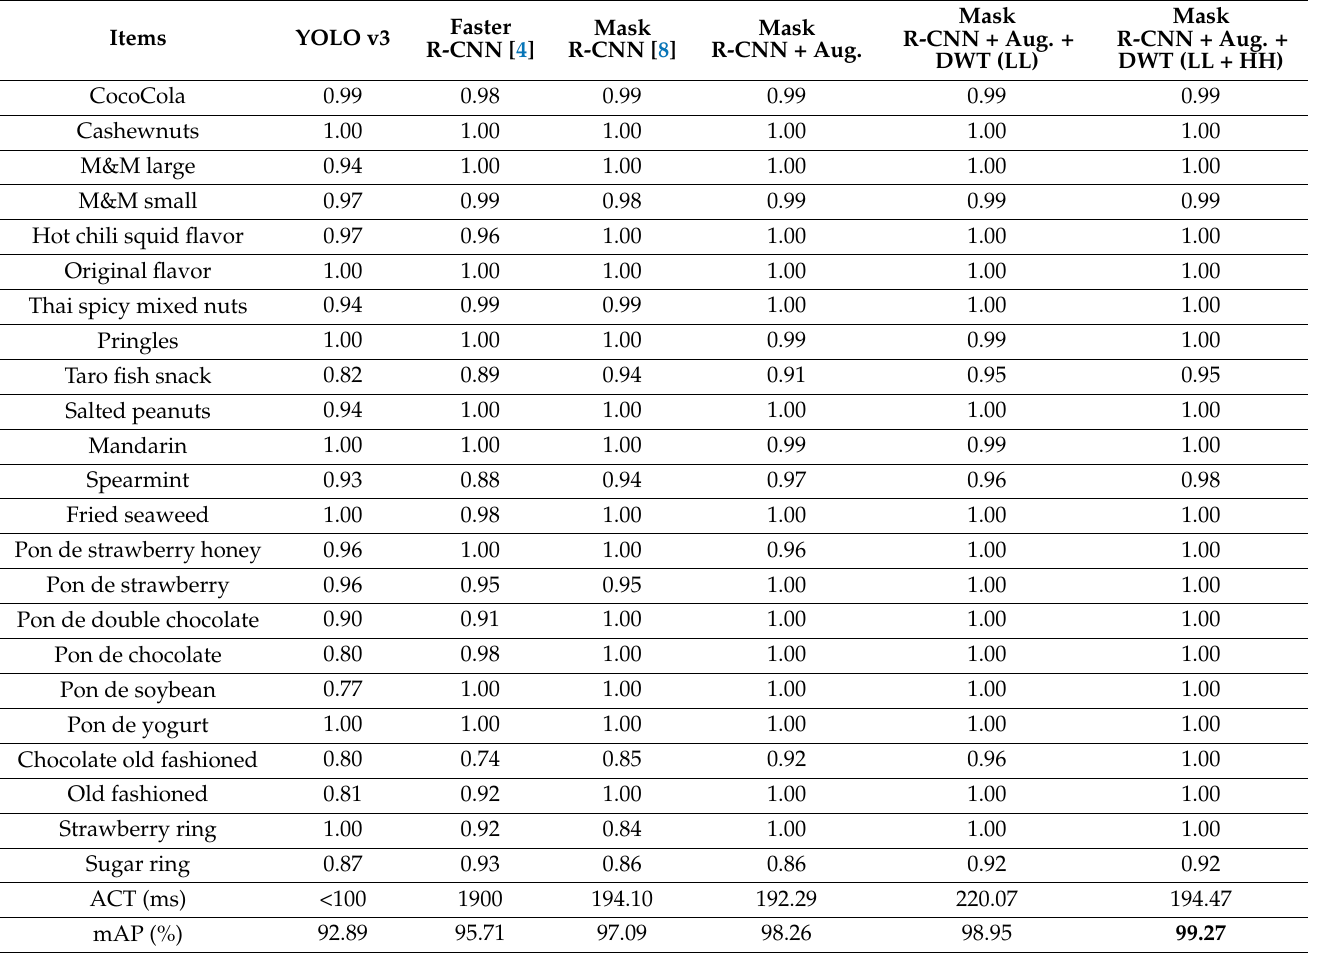
Table 7. Comparison of APs using different algorithms for each